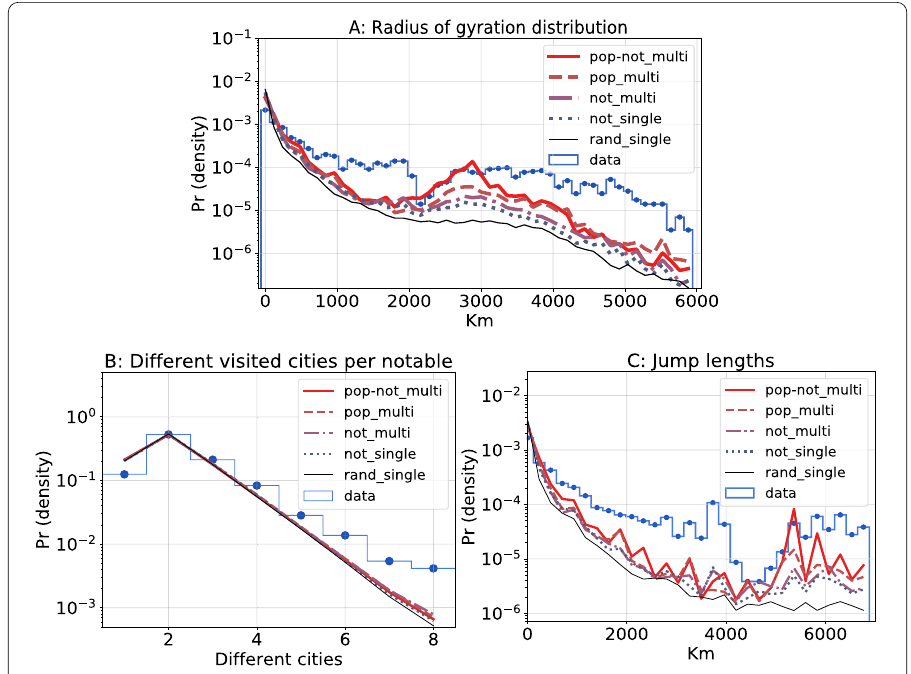
Figure 6 ( A ) The distribution of the radius of gyration per notable person. ( B ) The distributions of the data and the five different models for the number of different cities visited per notable person ( C ) The distribution of the lengths of the all the jumps simulated for the different model (lines) and for the data (stepped density histogram)